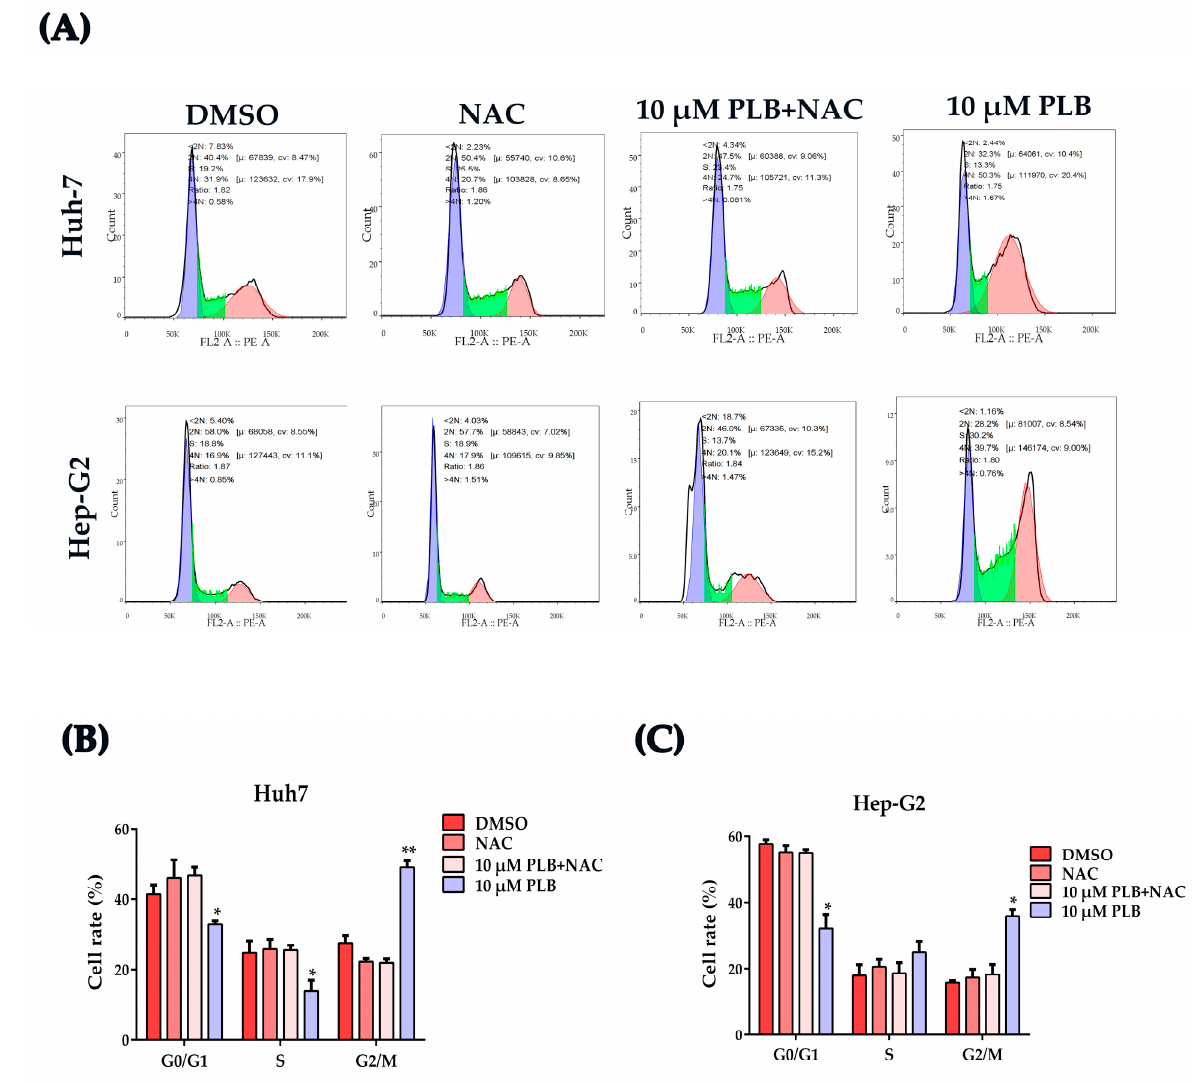
Figure 7. NAC pretreatment reverses the G2/M cell cycle arrest effects induced by plumbagin. ( A ) Representative images from the flow cytometry. Huh-7 and Hep-G2 cells were pretreated with 10 mM NAC for 1 h and were then treated with 10 µ M plumbagin for 12 h, respectively. ( B , C ) Cell percentage at different cell cycle stages was analyzed based on the flow cytometry results; * p < 0.05, ** p < 0.01 compared to the DMSO group; three independent experiments were performed.